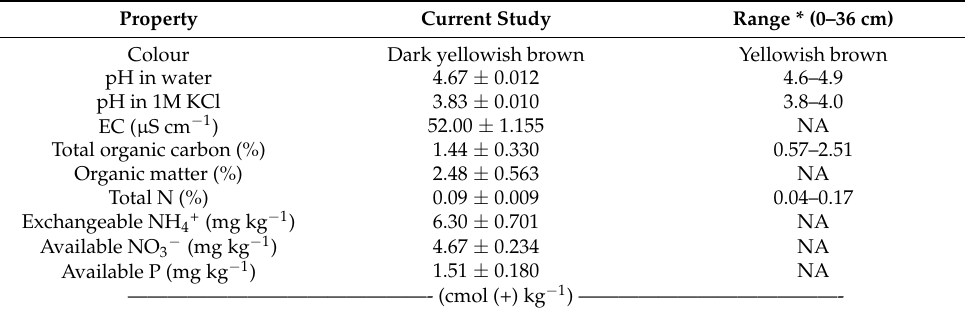
Table 2. Selected physical and chemical properties of Bekenu Series.